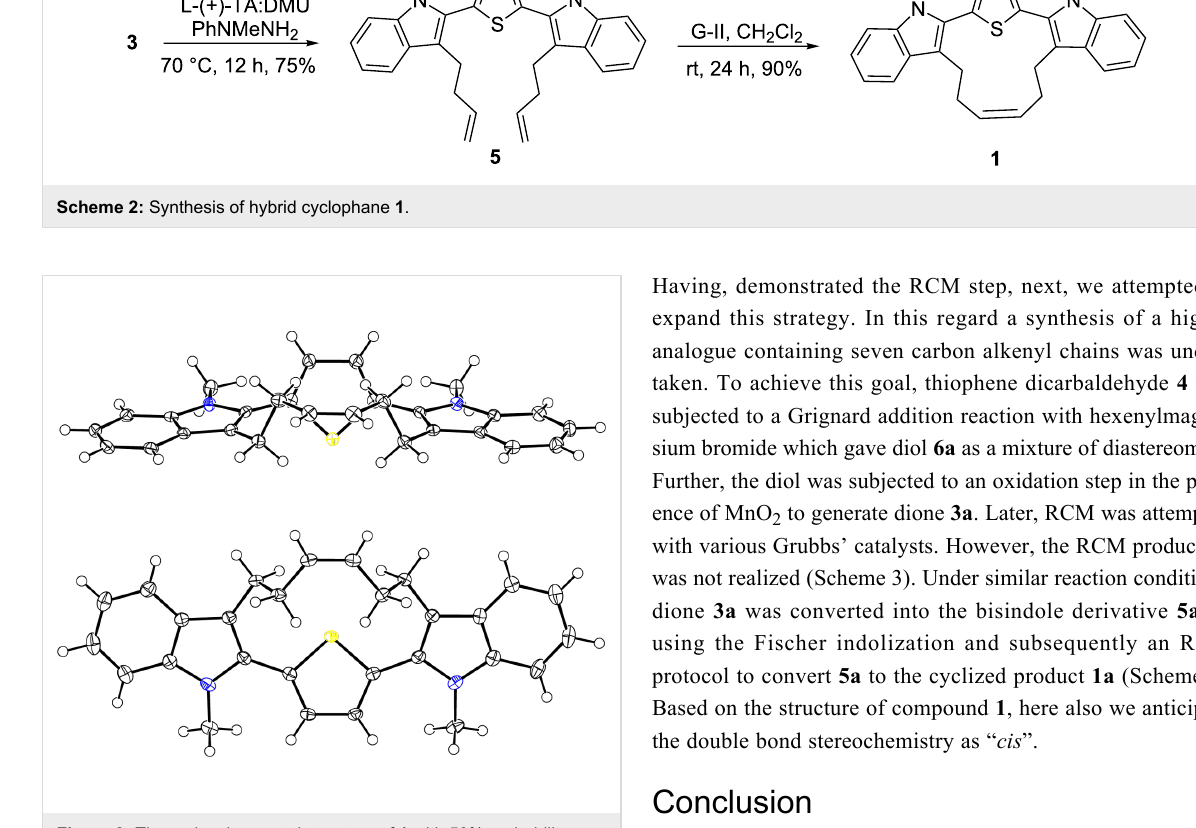
Figure 2: The molecular crystal structure of 1 with 50% probability